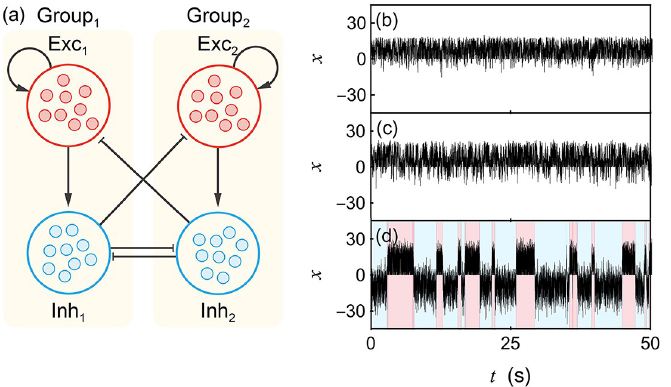
Fig 10. Network structure and simulated time series of internal variable x . Panel (a) shows that the system has two identical groups (Group 1,2 ) of neurons with symmetric connections. In each group, there is one cluster of excitatory neurons and one cluster of inhibitory neurons. Each cluster consists of an equal number of K /4 neurons. The connections between clusters are as shown. The synaptic strength is μ e from any excitatory neuron and μ i from any inhibitory one. In panel (b), (c) and (d), we plot the time series of x for a representative neuron in Exc 1 , with fixed inhibitory strength μ i = − 4.0. The system exhibits: in panel (b), monostability with μ e = 0.7; in panel (c), fluctuation = 1.2; in panel (d), bistability with μ = 1.7. Parameters: K = 40, h = 1 Hz, a = ln(100)/20 � 0.23, τ = 10 with μ e e